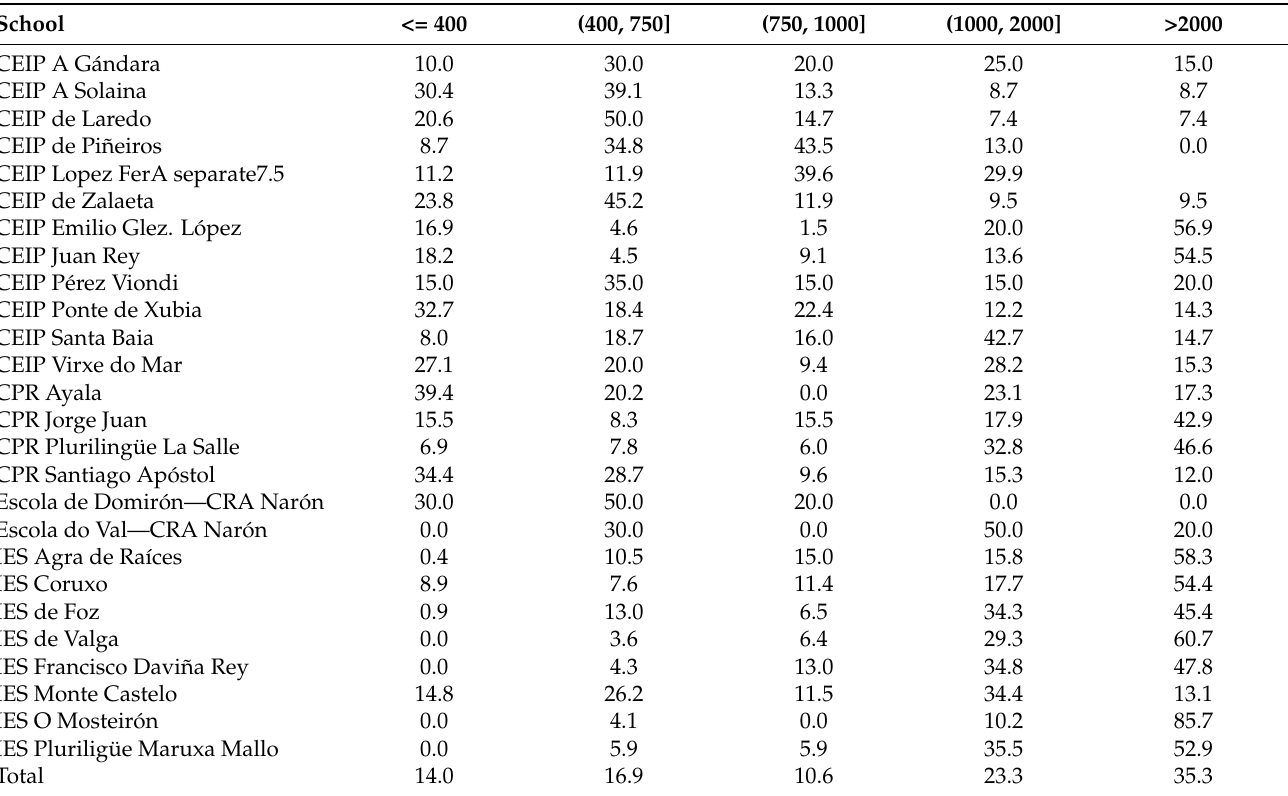
Figure 11. Home–school travel distances differentiated by means of transport. Table 12 shows the result of the count of households by distance zones from the schools, calculated from the road network in the vicinity of each school. Table 12. Household count in each distance zone. Separate survey for each school. Address count is shown in percentage values. Distances are shown in